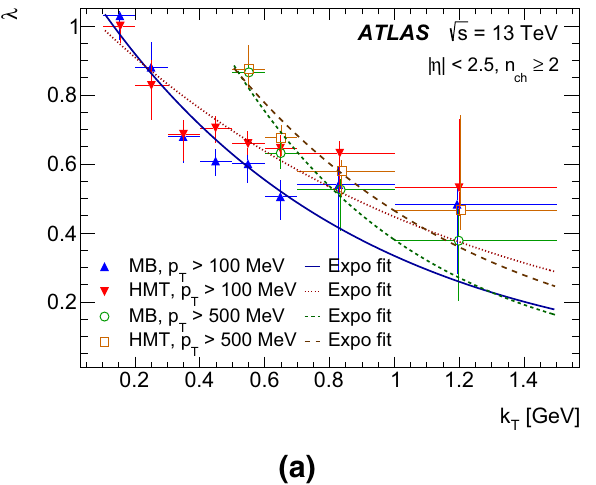
Fig. 6 The k T dependence of a the correlation strength, λ( k T ) , and b the source radius, R ( k T ) , obtained from the exponential fit to the R 2 ( Q ) correlation functions for events with multiplicity n ch ≥ 2 and transfer momentum of tracks with p T > 100 MeV and p T > 500 MeV